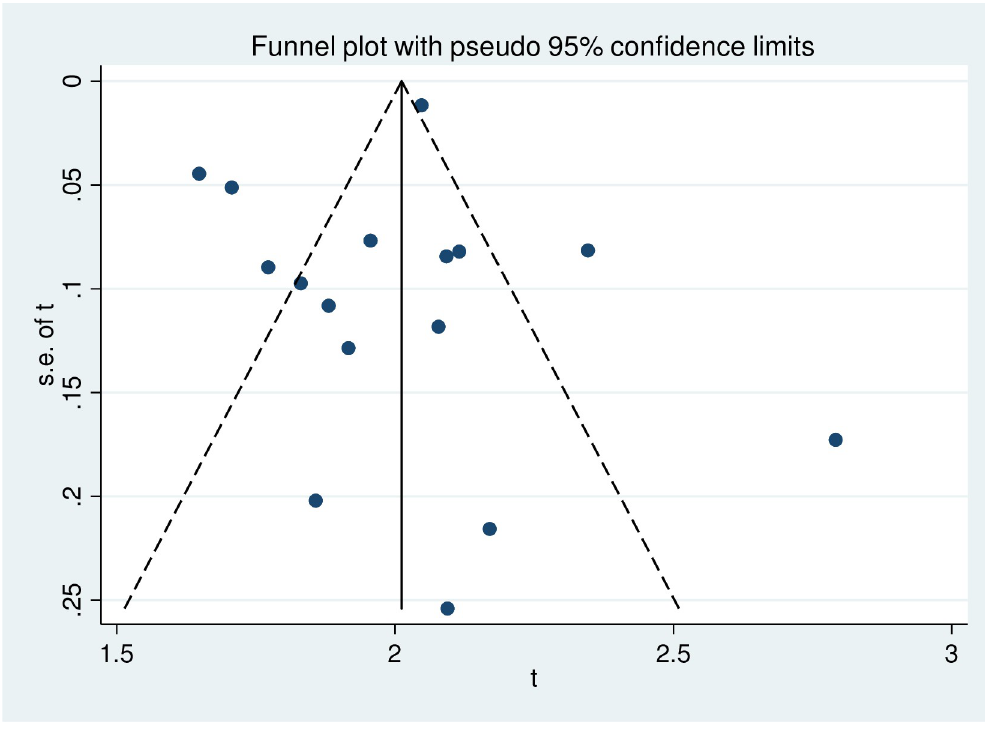
Fig 3. Meta funnel plot for publication bias. Prevalence estimate of MDR-TB among previously treated TB cases in East Africa, 2007 to 2019. Abbreviation: t: arcsine transformed prevalence estimate of MDR-TB and se of t, standard error of t.